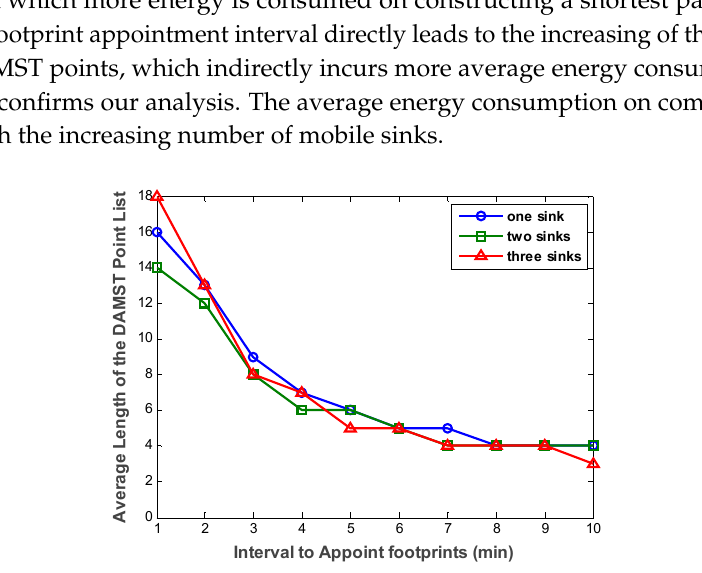
Figure 11. Average length of the DAMST point list with different footprint appointment intervals.